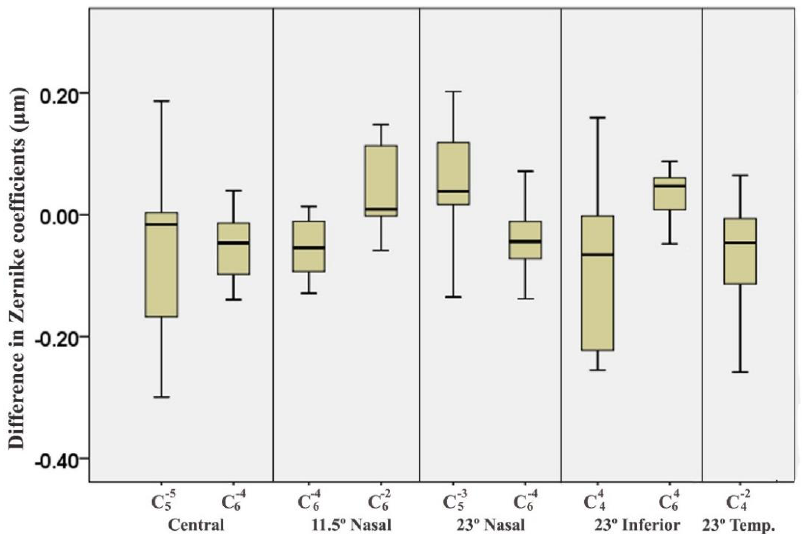
Figure 2. Box plot of the mean difference (non-accommodated-accommodated state) of Zernike coefficients, which were affected by